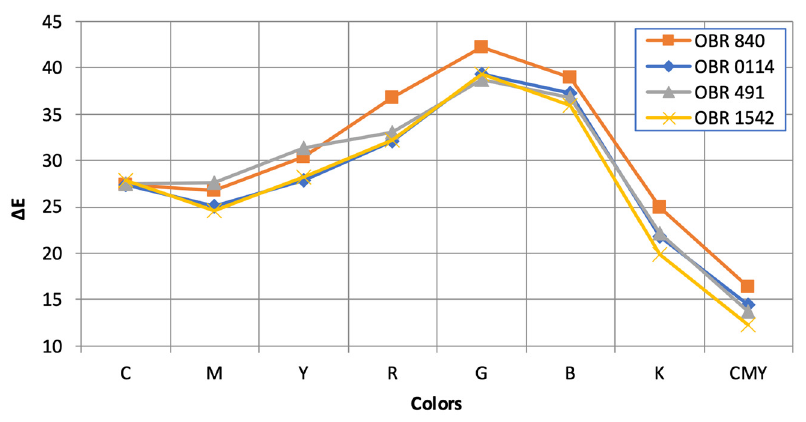
Figure 11. Different colors changes of Δ E on bleached linen fabrics when printing in 4 passes with 2 ink layers.